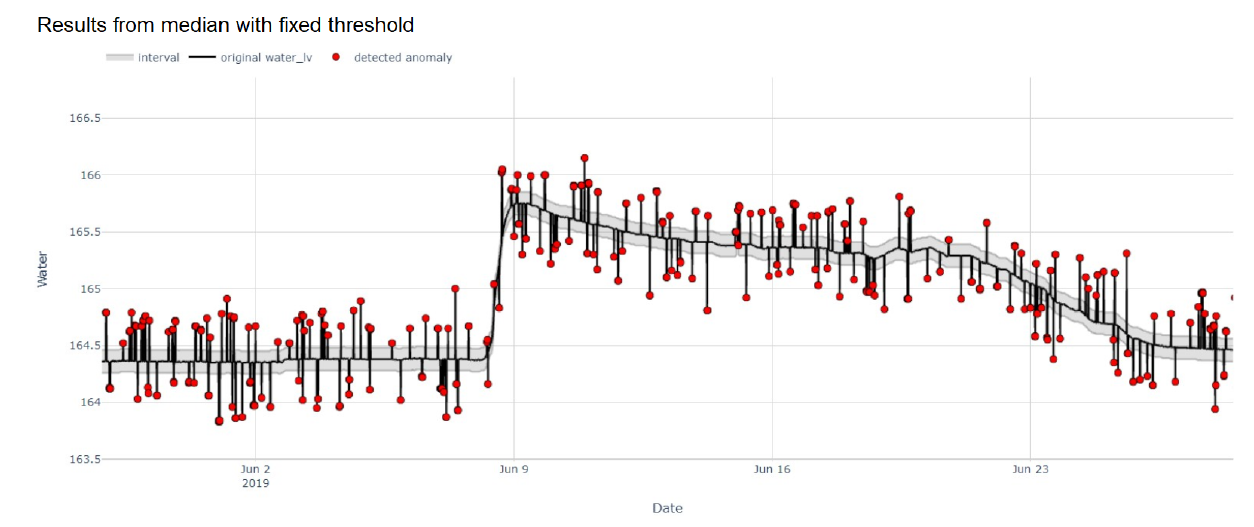
Figure 10. Example of the median with fixed threshold applied on the additional data with anomalous step changes.